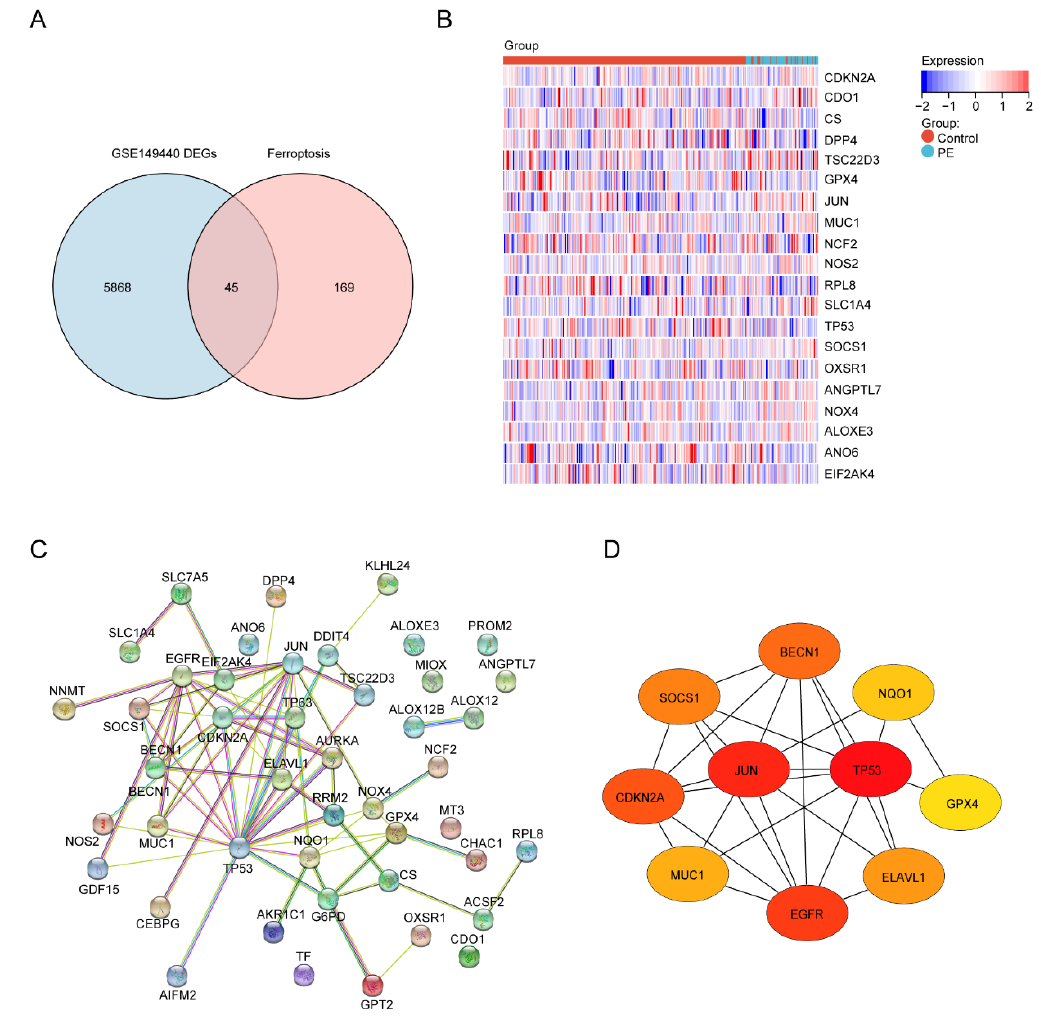
Figure 4. Identification of the ferroptosis-related DEGs and the identification of candidate ferroptosis-related hub genes in the blood samples of PE. ( A ) Venn diagram of the ferroptosis-related DEGs. ( B ) Heatmap depicting the expression levels of the top 20 ferroptosis-related DEGs. ( C ) PPI network analysis of the ferroptosis-related DEGs. ( D ) Ten hub genes were selected by the CytoHubba plug-in in Cytoscape. Table 4. Intersection of the DEGs and ferroptosis-related genes.